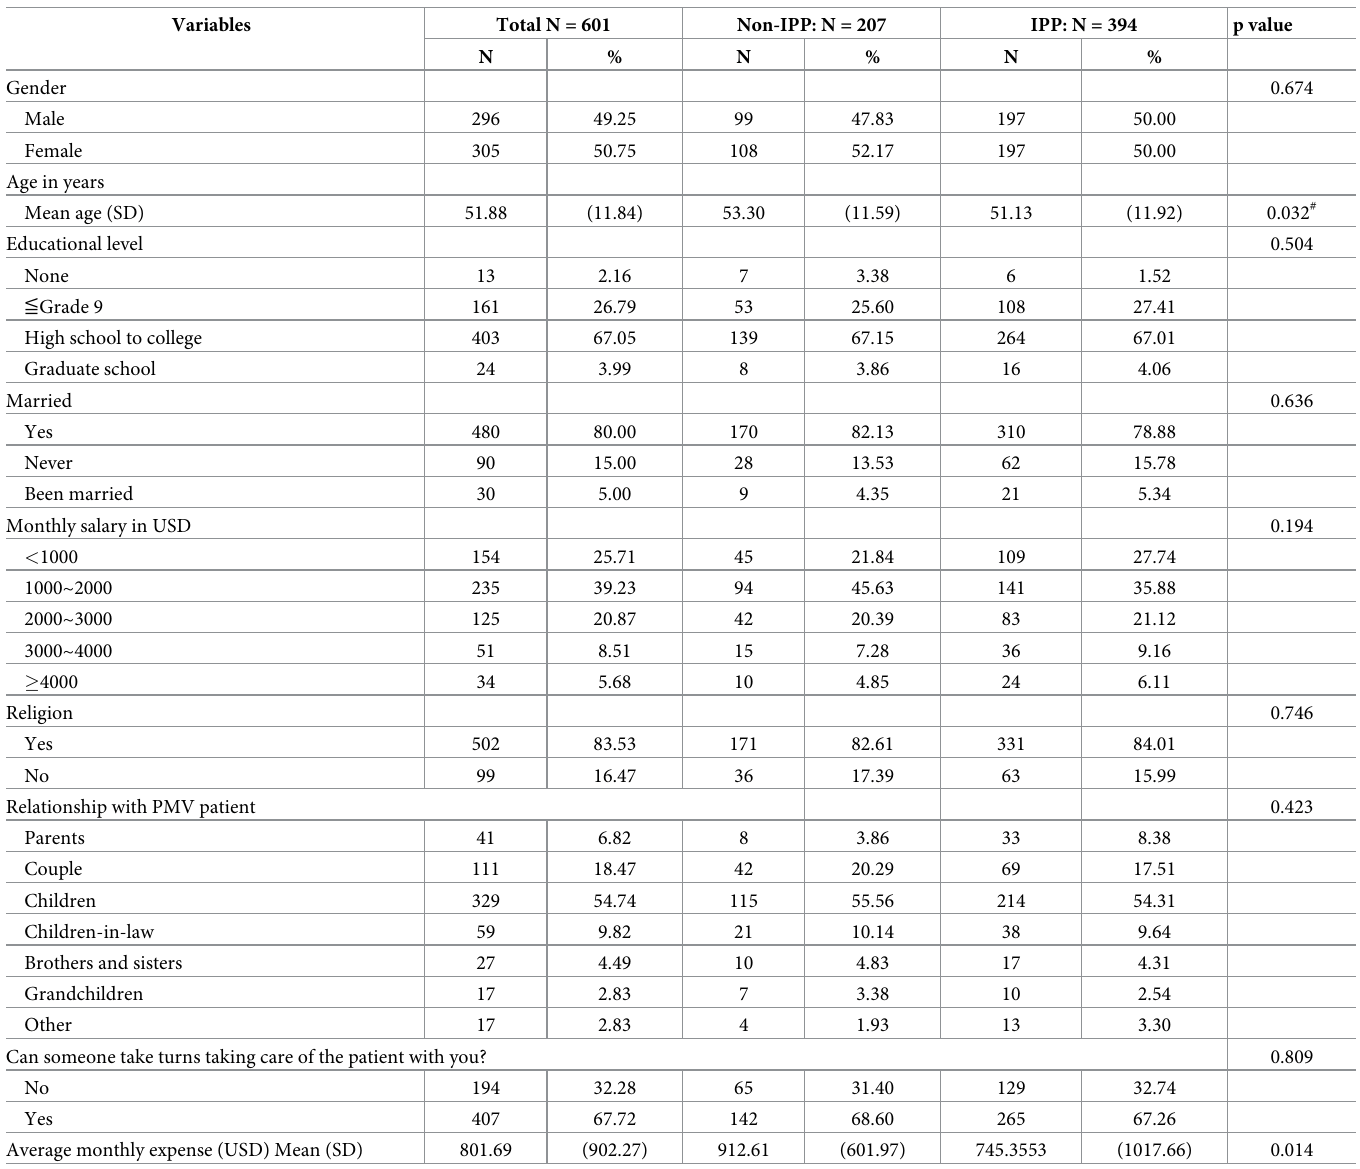
Table 1. Demographic characteristics of respondents with and without